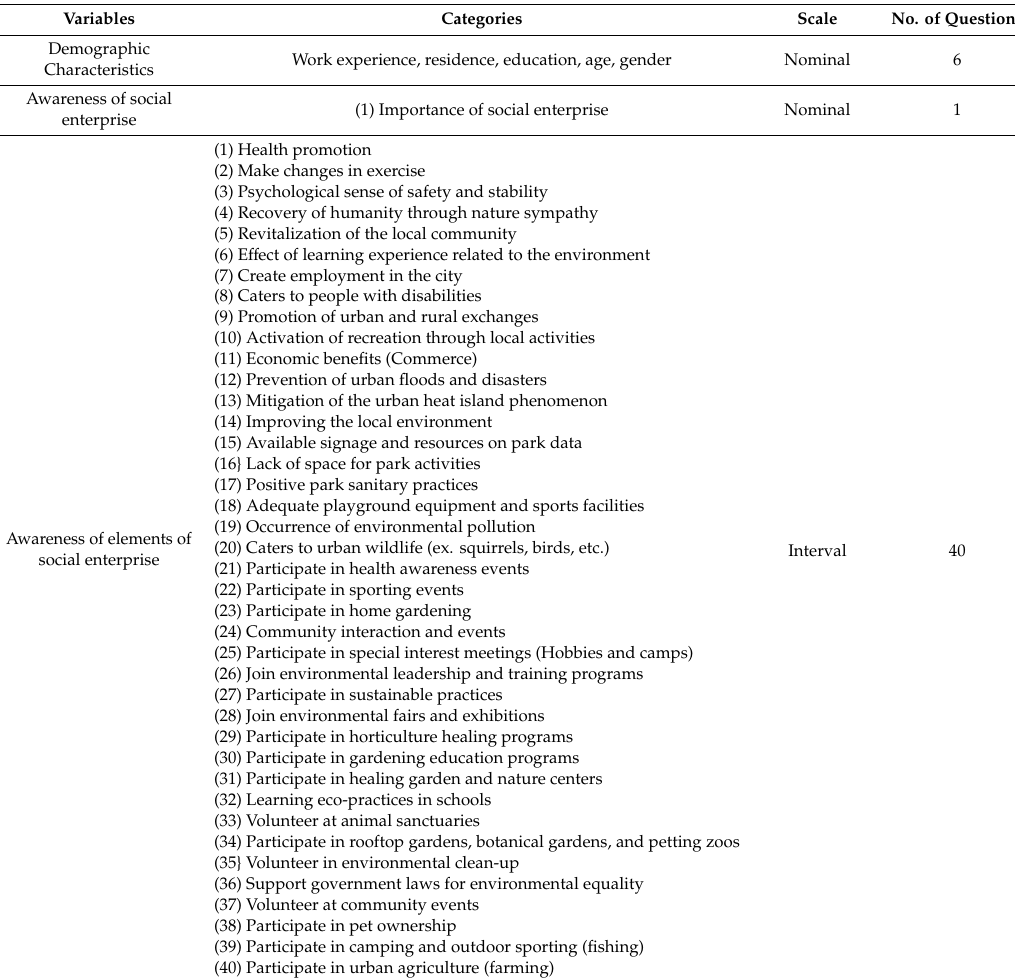
Table A1. Survey